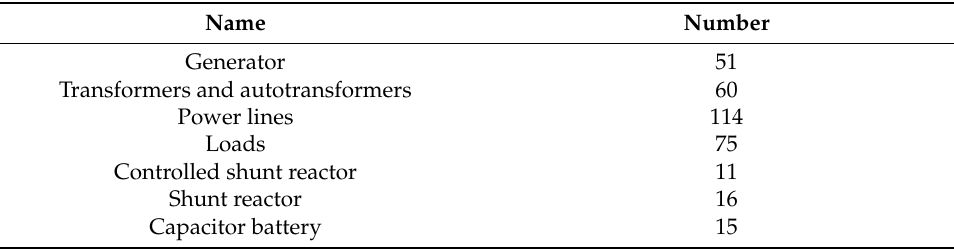
Table 1. Composition of elements of the modeled